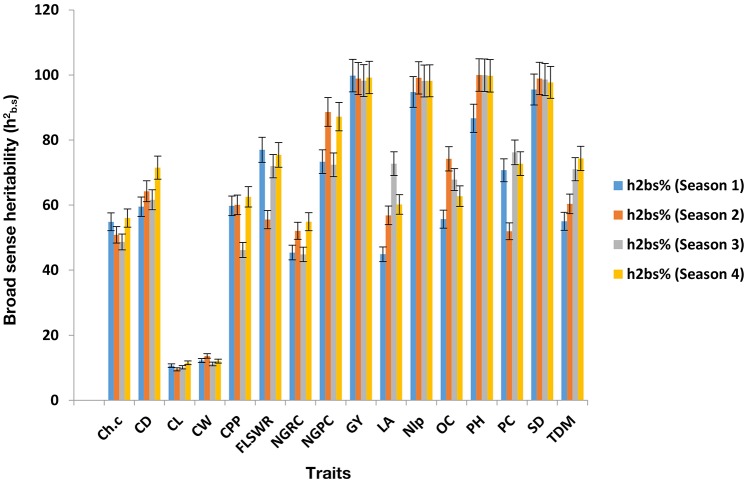
Broad sense heritability (hb.s2) estimates of under study traits in H9. The error bars are Standard errors (±).